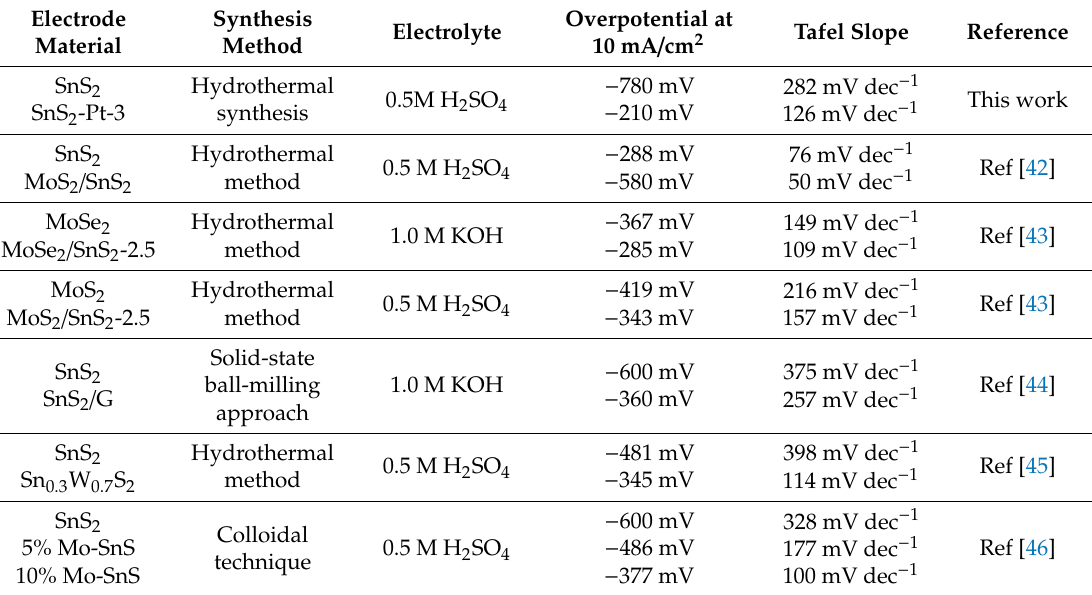
Table 1. Comparison table of electrocatalytic performance data of SnS 2 and its